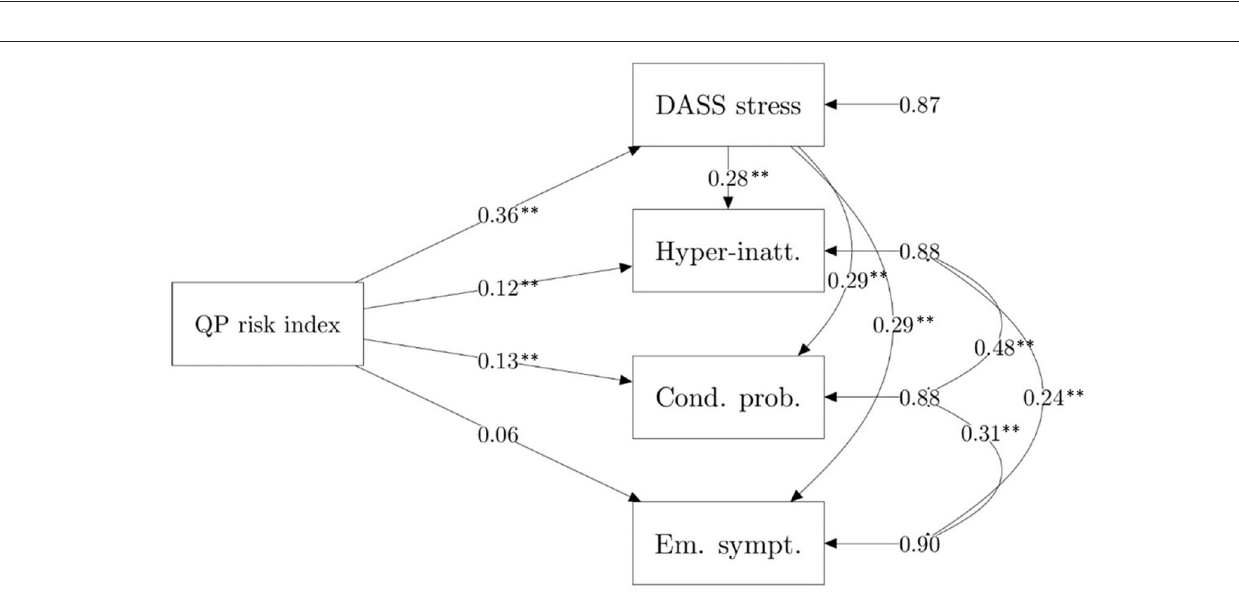
FIGURE 2 | Multivariate mediation model, including individual parent stress (DASS stress) as a mediator. QP risk index, Quarantine parent risk index. ** p < 0.01.